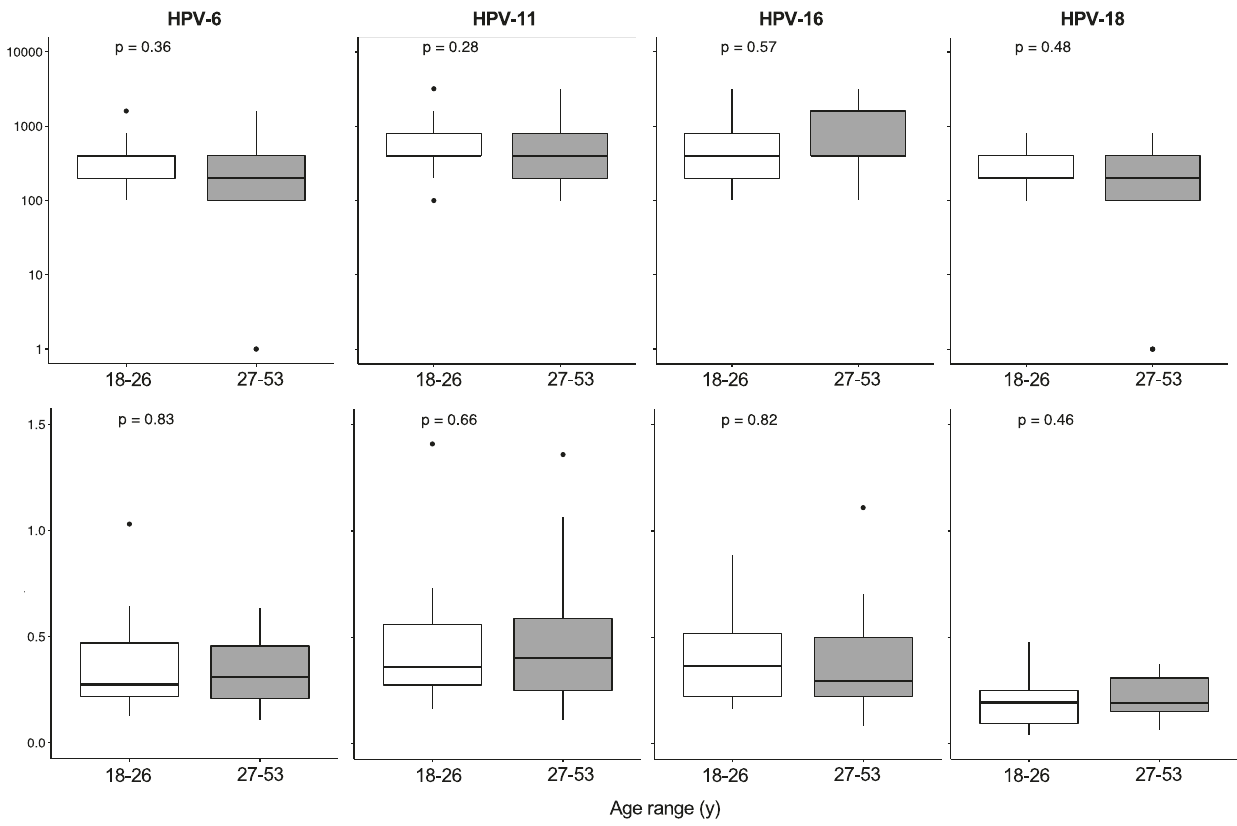
Fig. 5 Induction and maintenance of HPV-speci fi c IgG and memory B lymphocytes in adults. a , b HPV-6, HPV-11, HPV-16, and HPV-18- speci fi c IgG titers measured by ELISA ( a ) and memory B lymphocytes measured by B cell Elispot assay ( b ) are shown as box and whisker plots after strati fi cation of adults for age range: 18 – 26 y and 27 – 53 y; n = 21 for younger adults and n = 23 for middle-aged adults. Box and whisker plots are as in Fig. 1. Statistical comparisons were made the Mann – Whitney test and all p -values are